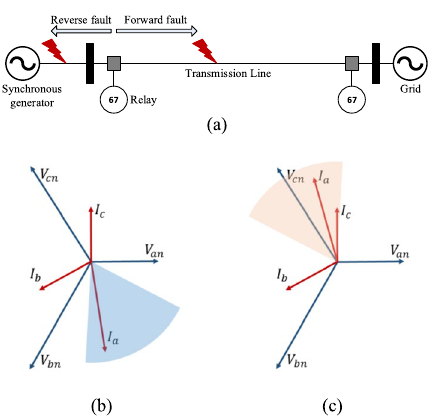
Fig. 7 Directional element operation. a General electrical system, b Blue zone means forward condition, and c Orange zone means reverse condition